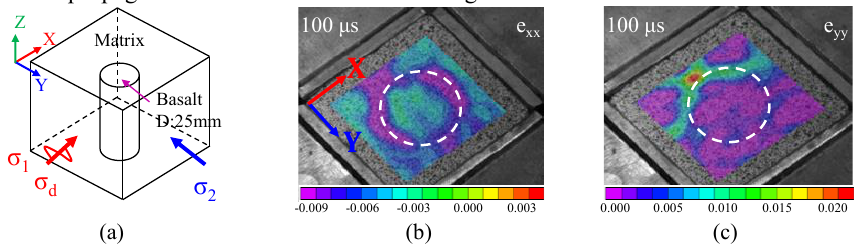
Fig. 5. Verification of strain fields around aggregate, (a) schematic of simplified matrix-inclusion sample, (b) axial strain fields and (c) lateral strain